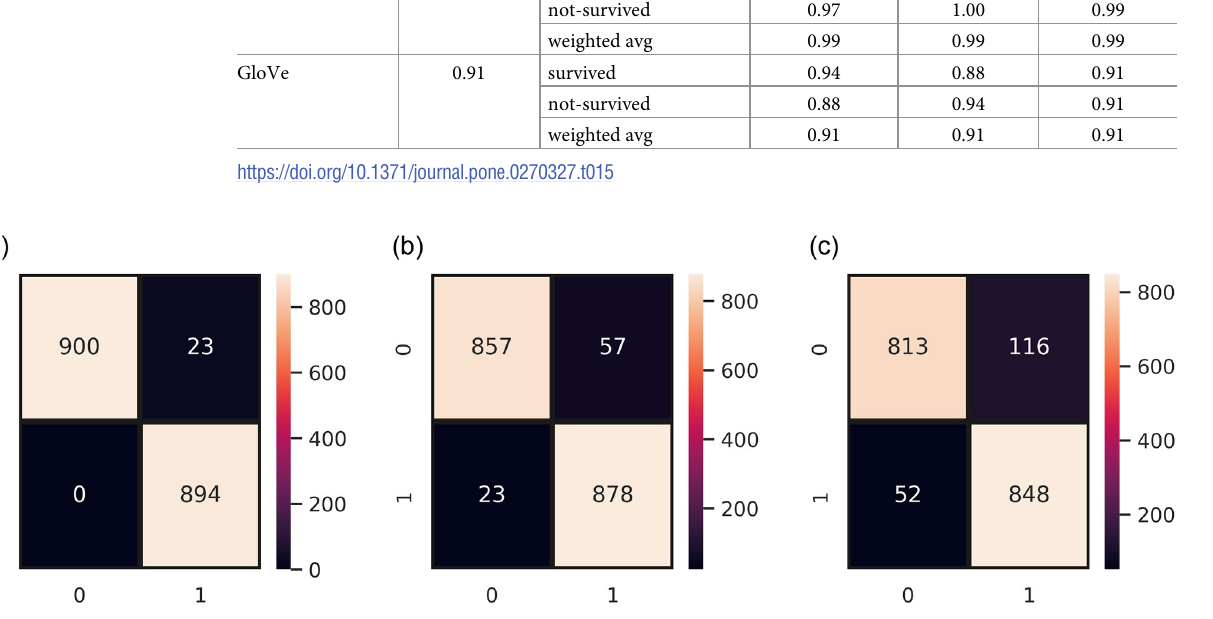
Fig 12. Confusion matrix of ER-VC concerning binary classification on ADASYN-balanced data, (a) ER-VC with TF-IDF, (b) ER-VC with BoW, and (c) RT-VC with GloVe.